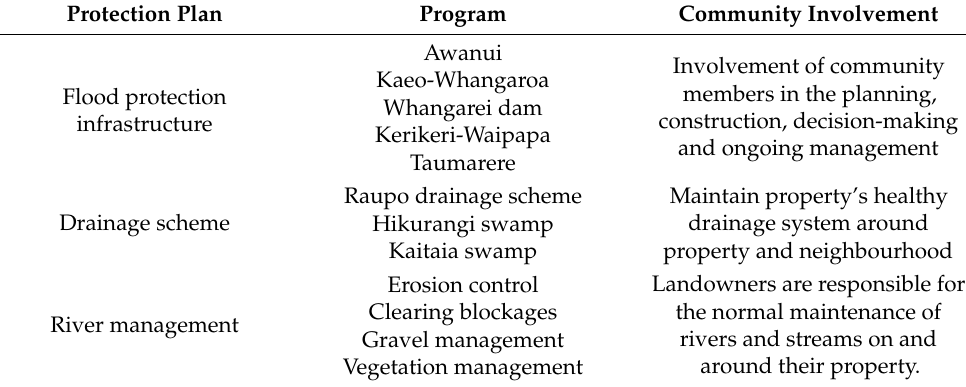
Table 3. Flood protection plan and community involvement (Source: